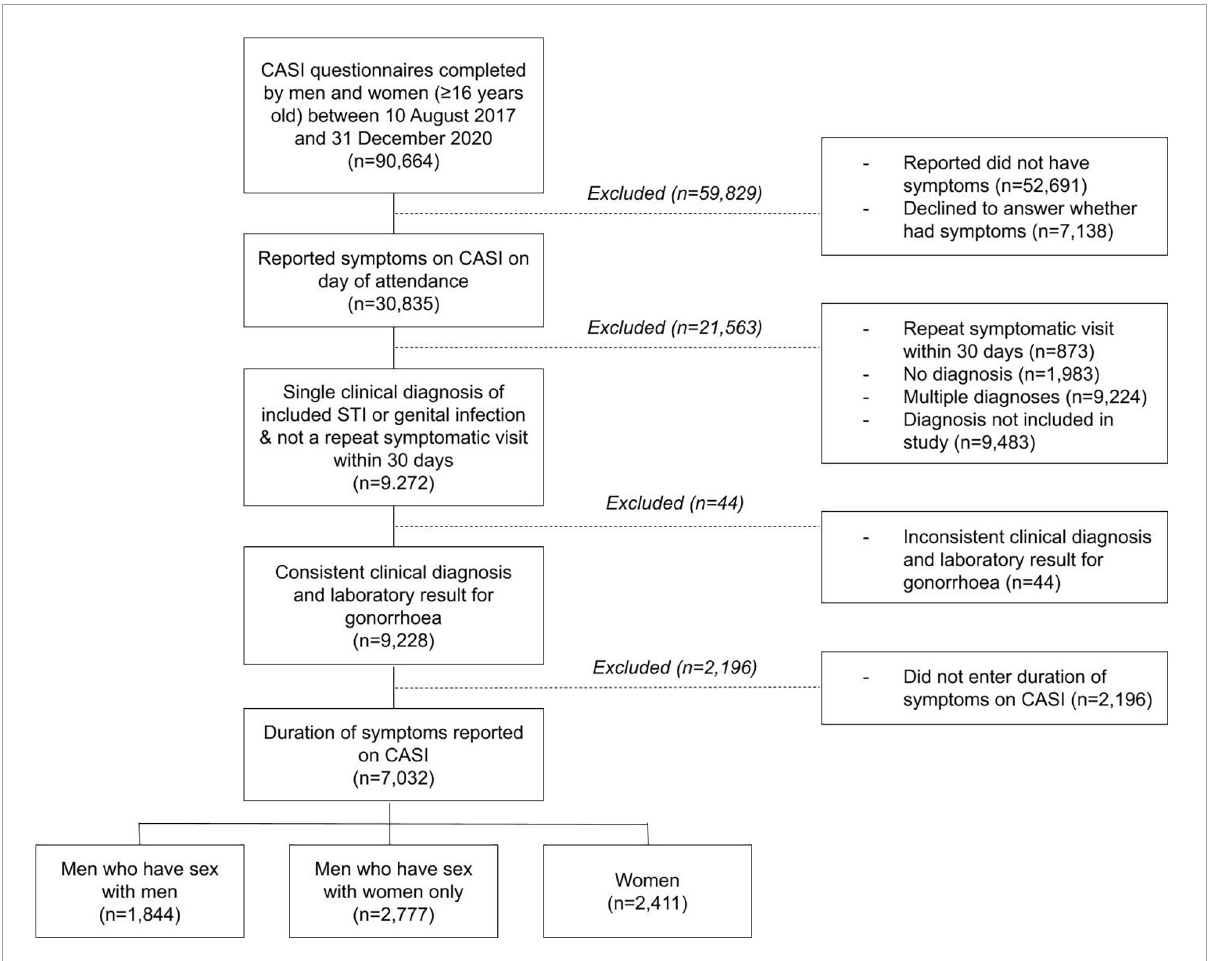
FIGURE1 Flowchart of the sample selection process. Individuals with one of the following 13 clinical diagnoses were eligible for inclusion: bacterial vaginosis, candidiasis, pelvic inflammatory disease, gonococcal urethritis, non-gonococcal urethritis, balanitis, molluscum contagiosum, proctitis, genital warts, anal warts, primary syphilis, secondary syphilis, and genital